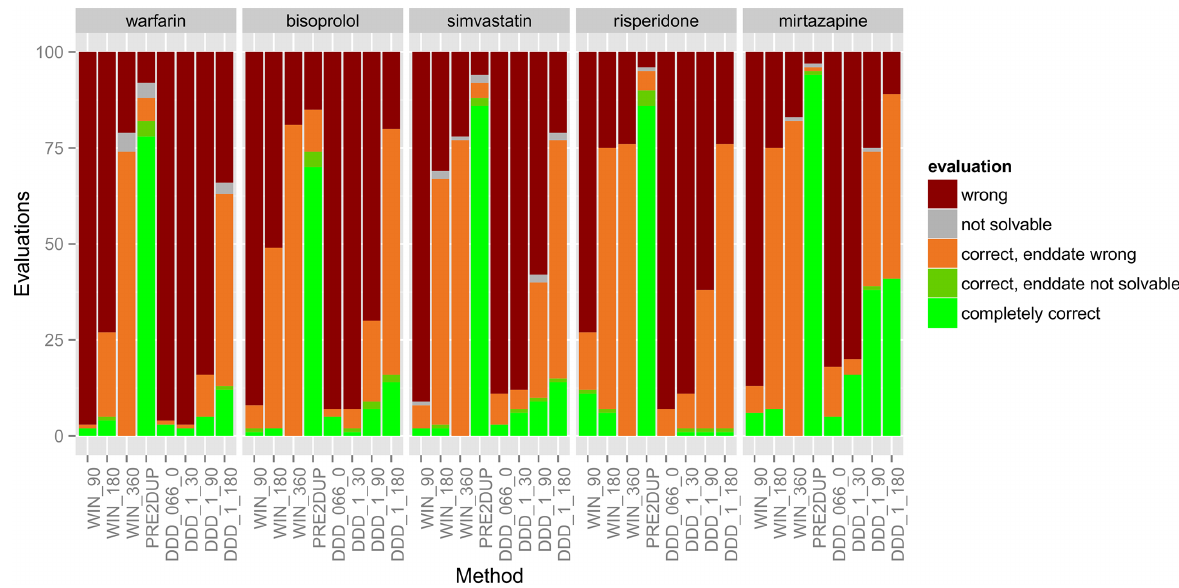
Fig 1. Evaluation results of 100 drug use periods produced by DDD methods along with PRE2DUP for five drugs. Abbreviations explainedin text.